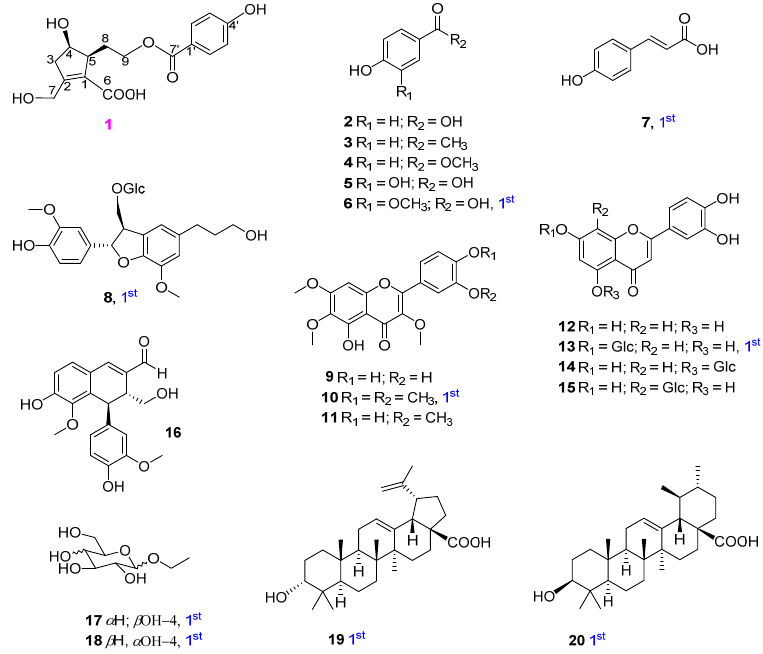
Figure 1. Structures of isolated compounds 1 − 20 from V . rotundifolia .